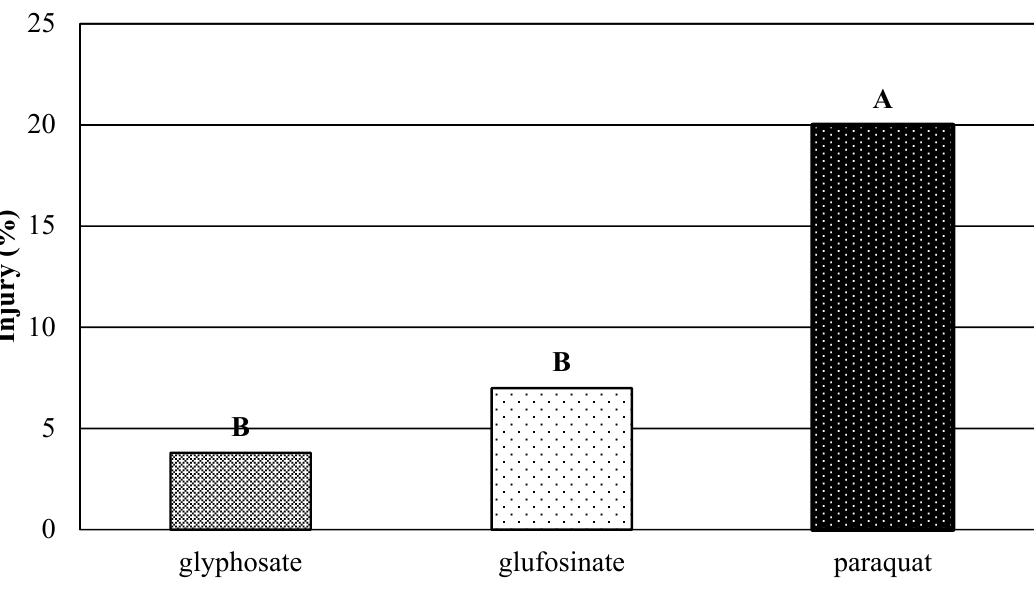
Figure 2. Grain sorghum injury from a simulated drift of glyphosate, glufosinate, and paraquat at 28 DAA in 2017. Data were averaged over application timings. Same letters on bars indicate no significant differences at p < 0.05, according to Fisher’s least significant difference test.